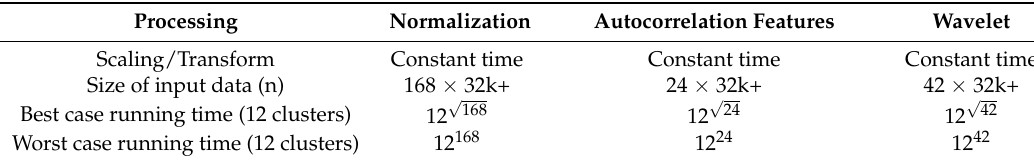
Table 4. Clustering method runtime comparison. The normalized and wavelet methods were unable to provide meaningful clusters and are for comparison set to 12 clusters and 25% compression for wavelets. The autocorrelation and wavelet method reduced the dataset size, with a significant impact on the runtime. The table is an adaptation from a table in